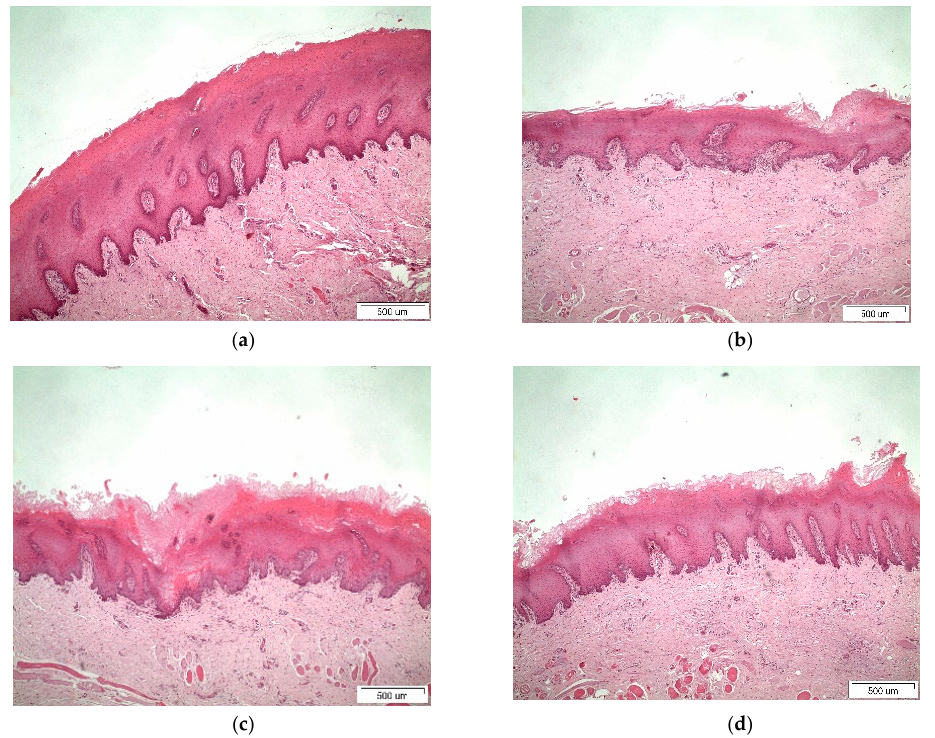
Figure 8. Light micrographs of tablet with ( a ) chitosan as control (without complexes); ( b ) β -CD; ( c ) Me- β -CD; and ( d ) HP- β -CD. Bar represents 500 μ m.